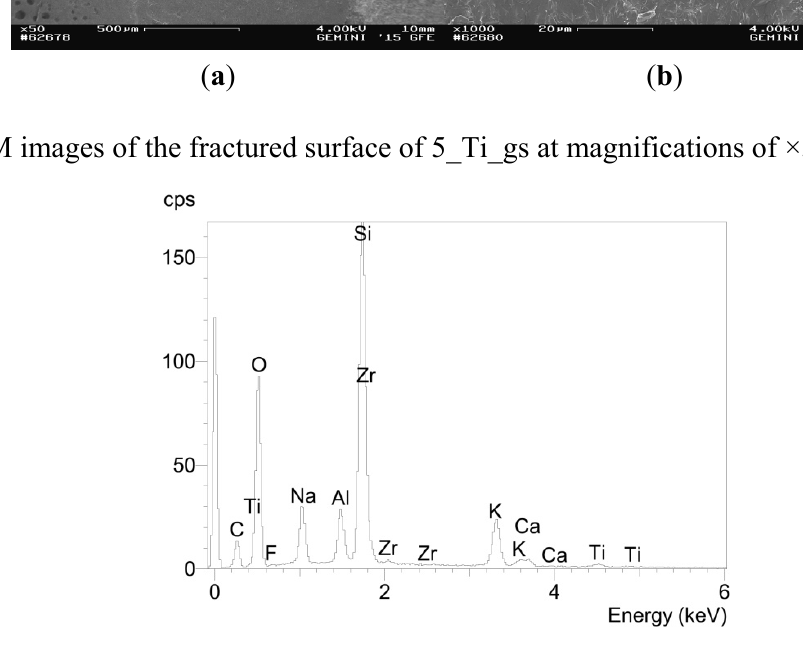
Figure 8. Elemental spectrum for sample 5_Ti_gs determined using EDX analysis.